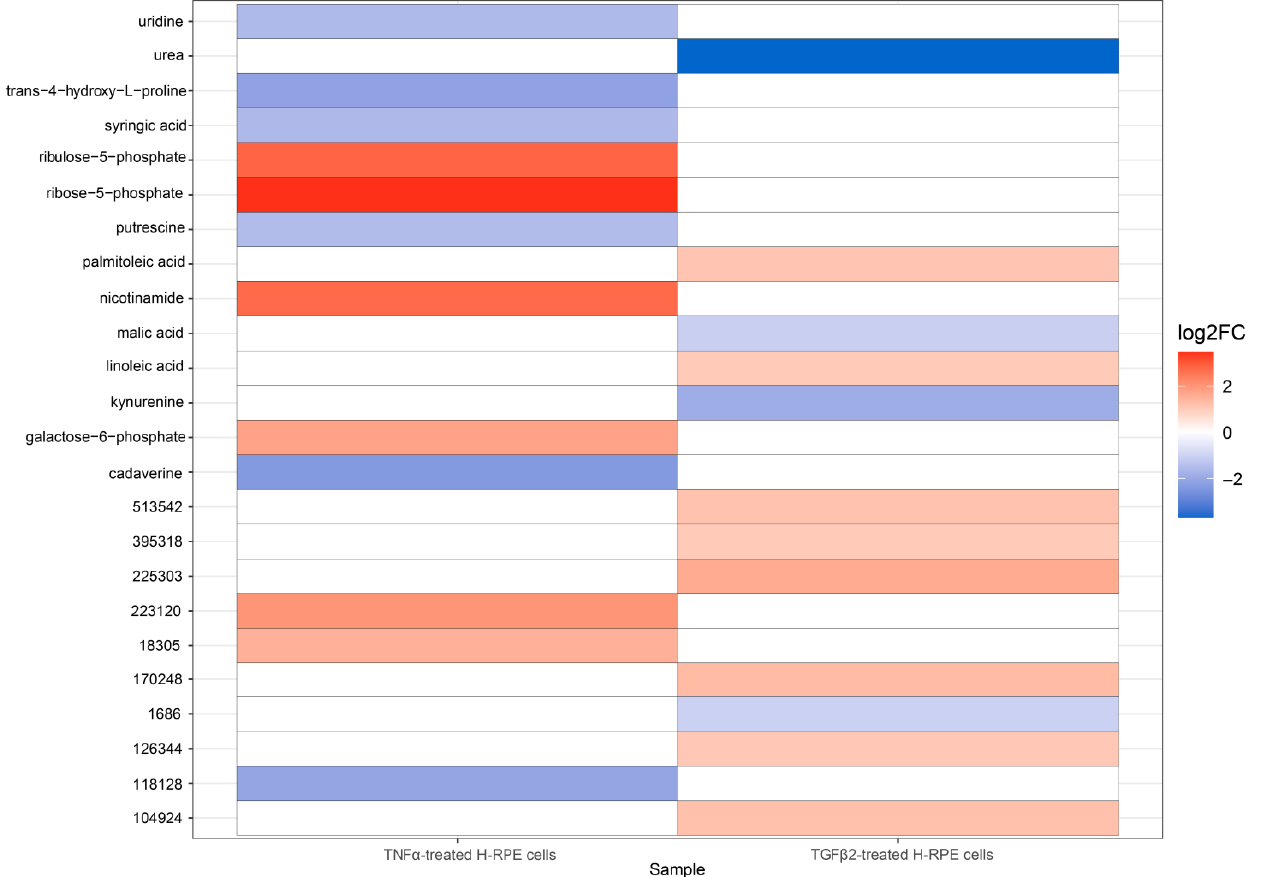
Figure 4. A heatmap depicting differential metabolite changes between TNFα - treated and TGFβ2 - treated H-RPE cells. Upregulated metabolites are displayed in red, and downregulated metabolites are displayed in blue. Both annotated (primary) and non-annotated metabolites were included in this analysis. p adj < 0.05.